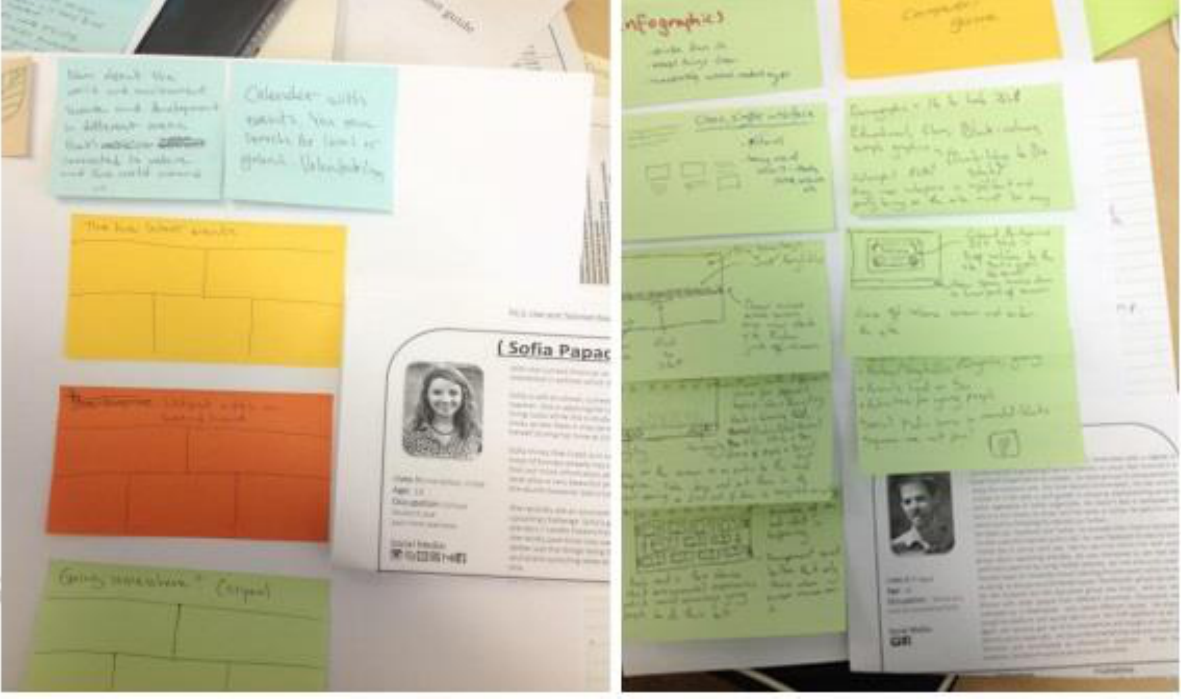
Fig. 3. Use of the personas in supporting the work with YEAs YEAs also produced interesting ideas for the landing page of the platform. We will concentrate on three examples. In a workshop conducted in Czech Republic (workshop 3), participants placed emphasis on having the home-landing page of the platform showing what happens at a local level, where local was intended from the city/village up to a country level. This can be seen in the two sketches in Fig. 4 where both “news from the locality” and a ta bs organisation of the homepage could facilitate this. However, participants also emphasized the importance of having features sup- porting Europe wide e-participation. For the landing page, participants also proposed a welcoming message about a “new generation” taking ownership and leading to deliver a better environmental